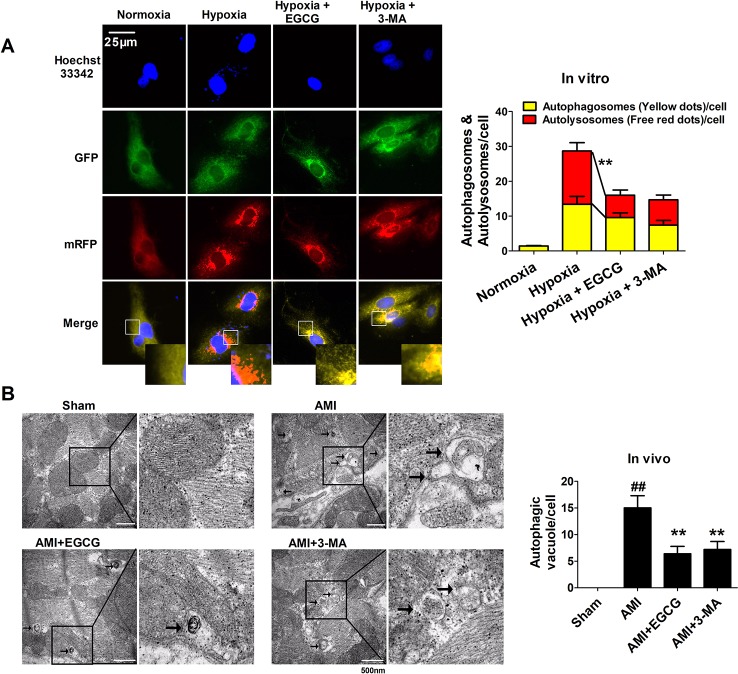
EGCG maintained cardiomyocytes against AMI injury by regulating autophagy. (A) Tandem mRFP-GFP-LC3B probe analysis of the autophagosome-lysosome fusion in vitro. Yellow dots represent the unfused autophagosome, whereas red dots denote the fusion, wherein autolysosomes are formed. At least 10 cells per group were counted randomly in three independent experiments. **p < 0.01 vs. other group. (B) Representative EM images were shown in vivo. The arrows depict autophagosome. Quantification of autophagic vacuoles was shown. Values were expressed as mean ± SD (n = 6). ANOVA testing was performed; ##
p < 0.01 vs. sham group; **p < 0.01 vs. AMI group.